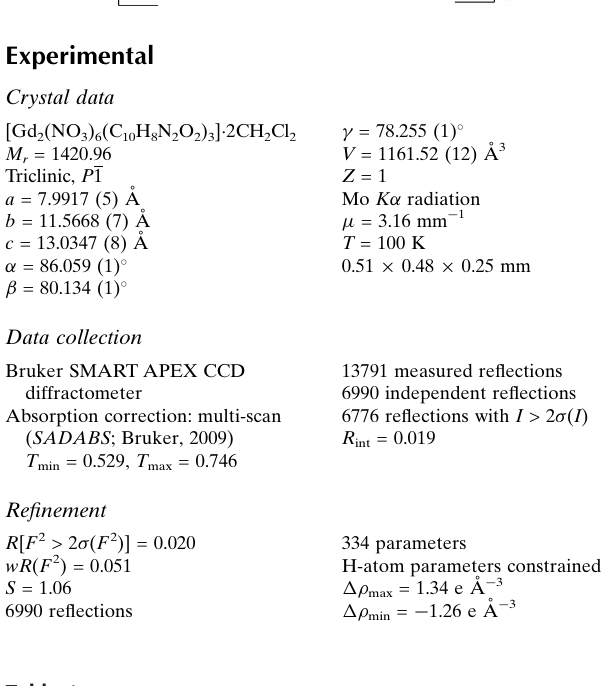
title one-dimensional coordination network,